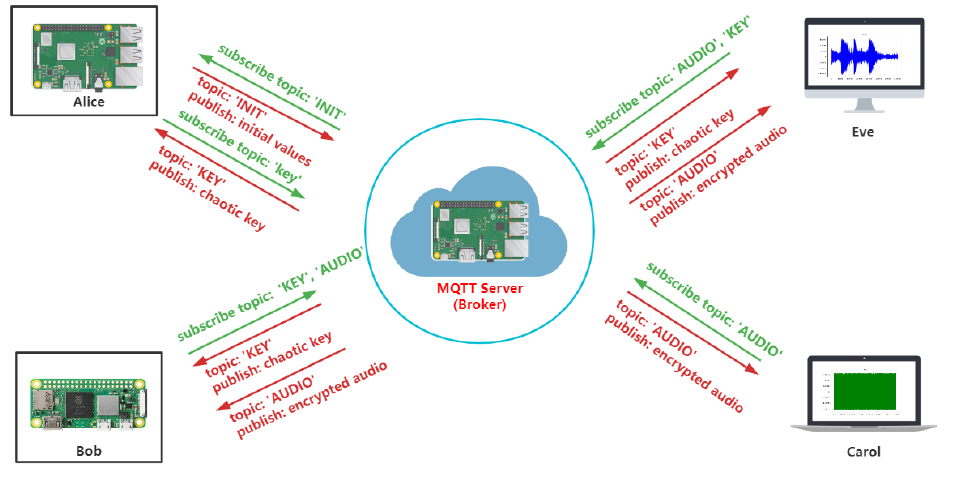
Figure 10. Topology structure of IoT Application under MQTT